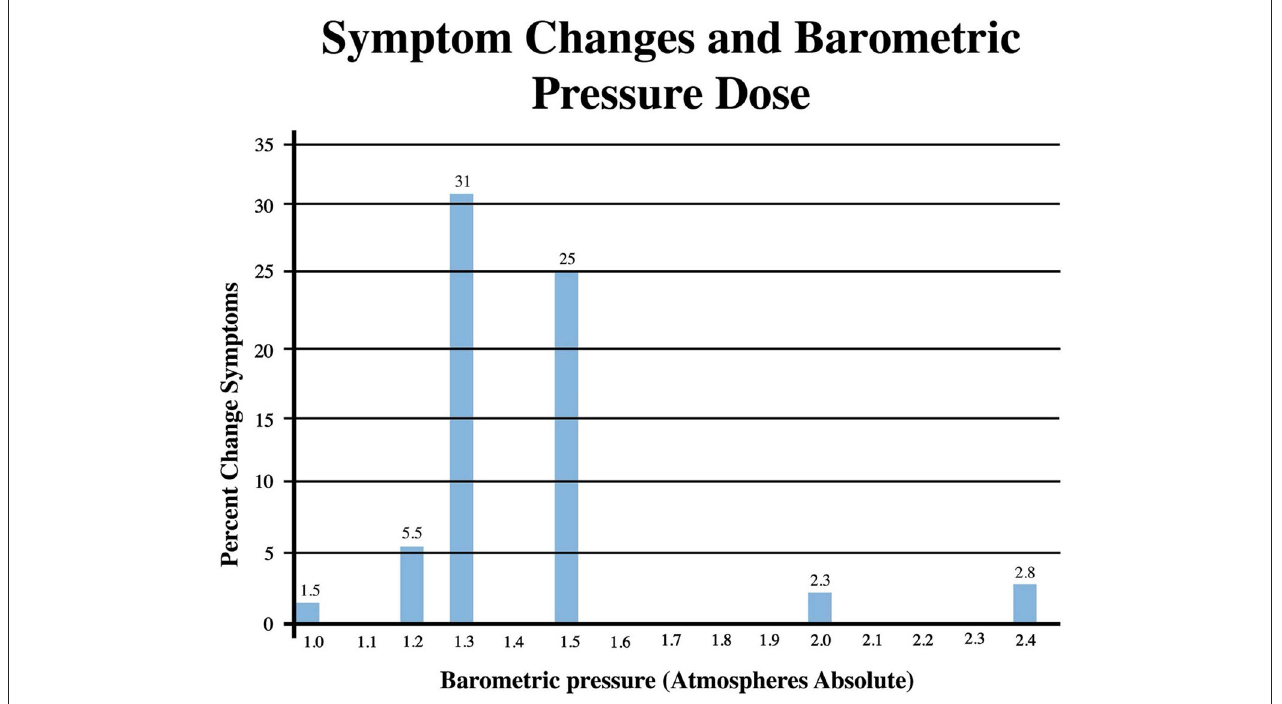
FIGURE 2 | Symptom Improvements from Table 2 vs. pressure dose for HBOT mTBI PPCS studies. Symptom percent values represent average percent improvement in symptoms at a given pressure in Table 2 , averaging the three different instrument (ImPACT, NSI, and RPQ) symptom